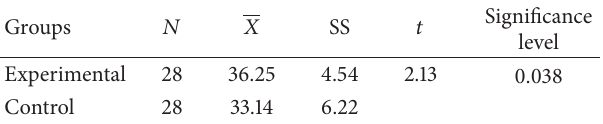
Table 6: Independent groups 𝑡 -test results related to the posttest scores of the experimental and control group.